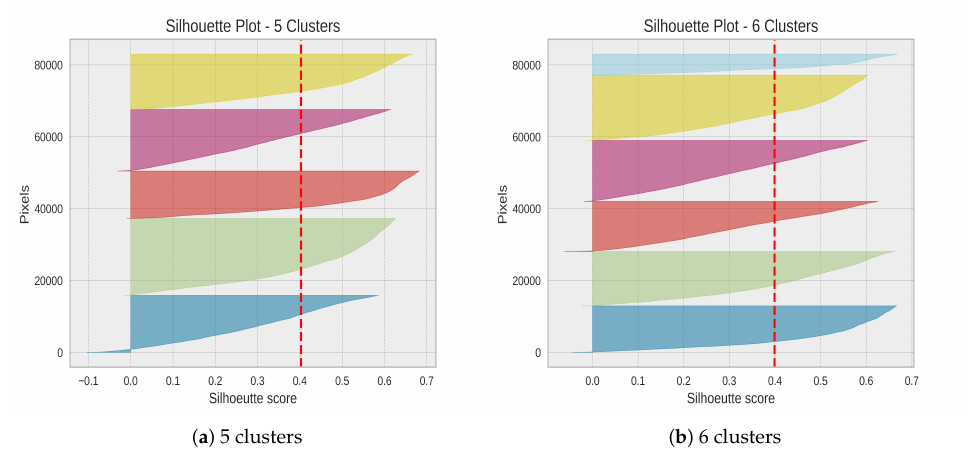
Figure 3. Silhouette Plot UMAP+k-Means for 5 and 6 clusters and the HRL000040FF